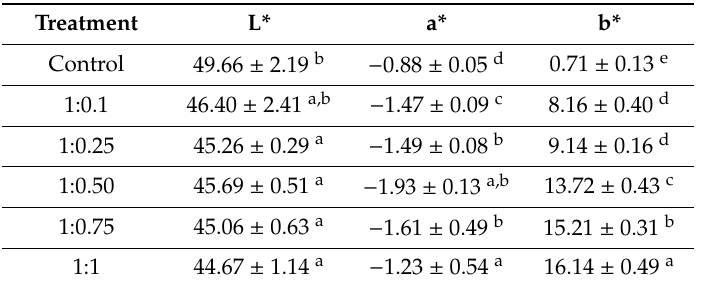
Values with the different letter a,b,c,d in the column are statistically different values according to the Tukey test ( p < 0.05).